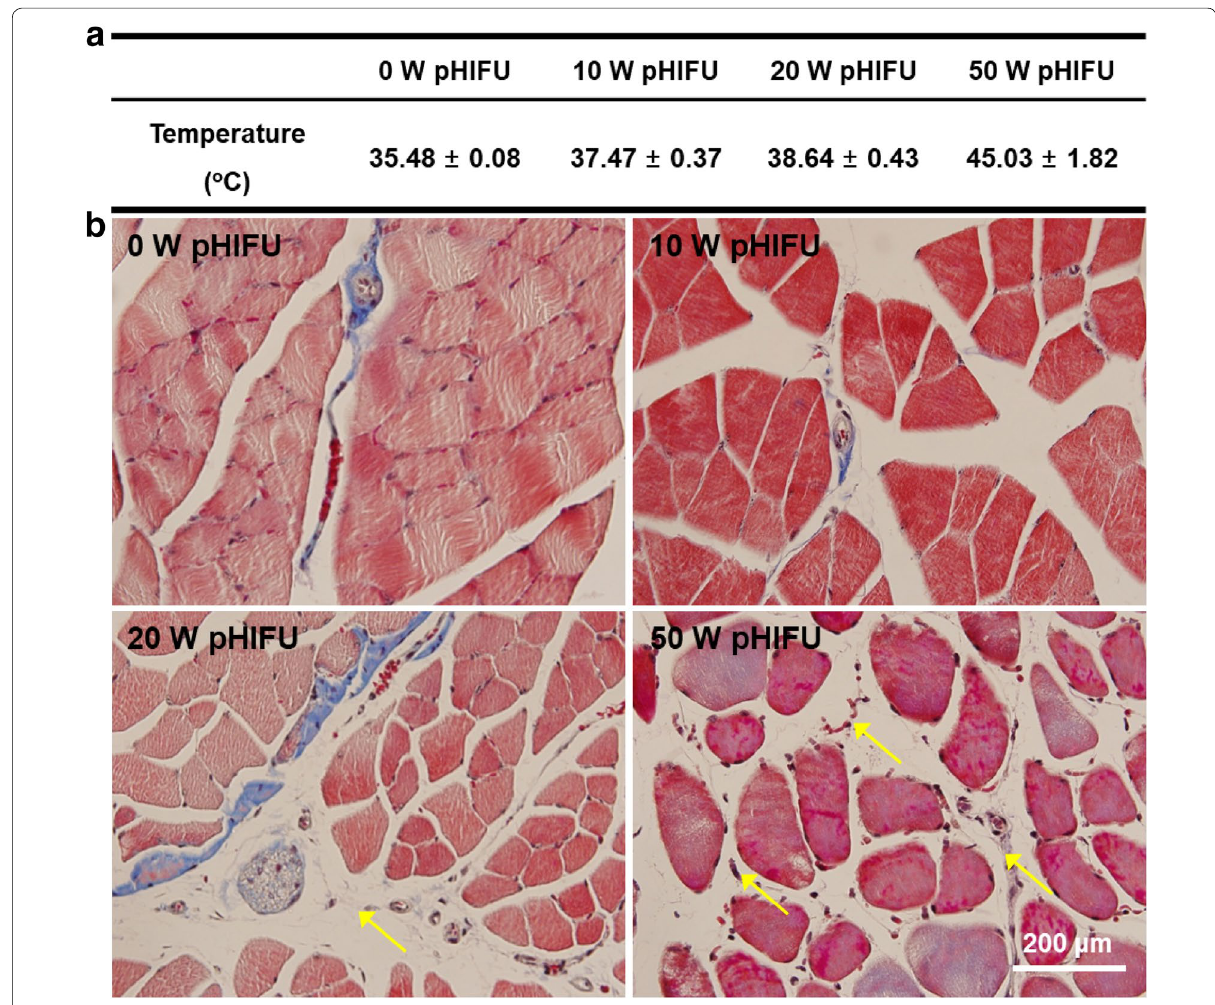
Fig. 3 pHIFU-induced hyperthermia effect in femoral tissues. a The temperature at femoral tissues after treatment of 10, 20, and 50 W pHIFU. b Masson’s trichrome (MT) staining images of femoral tissues after treatment of 10, 20, and 50 W pHIFU. Scale bar indicates 200 µm. Yellow arrows indicate the histopathological abnormalities, such as the edema and chapped red blood